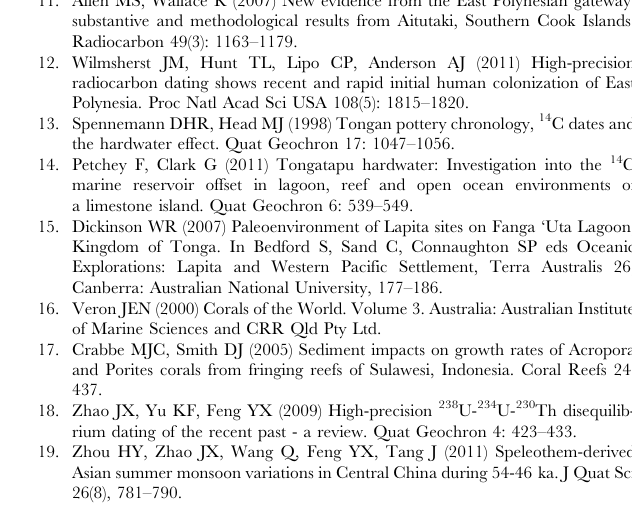
Figure S1 Nukuleka Site Excavation Map. Nukuleka site excavations (darkened blocks) and mound perimeter (dark dashes). The north/south trench through the mound was excavated in 1965 [1] while the remainder was carried out by Burley [5]. Excavation unit numbers cross reference with Table S3. Stippled areas are roads, dashed lines represent fences and hatched rectangles are structures. Figure S2 Nukuleka Excavation Stratigraphy. Block excavation north face stratigraphy (see Figure S1 for location). Stratum III occurs only in the west half of this section. Stratum IV is the yellow coral sand beach beneath the midden deposit. Stratum III/IV is the interface between the beach and midden. Figure S3 Sample Sections and Cleaning. Photos showing sample cleaning steps and representative samples used for U/Th dating. See Text S2 for details. Note the differences between pristine sample 2011-024 (upper left) and the darker sample 2011- 027 (lower left) resulting from diagenetic alteration. Table S1 Radiocarbon Dates for Nukuleka. Radiocarbon dates for Nukuleka [5]. For ANU 541, Spennemann and Head [18] employ a lagoon specific reservoir correction to provide a corrected date of 2819 6 89 BP and a calibration range as given. Calibration for the remainder is carried out using the Calib 5.1